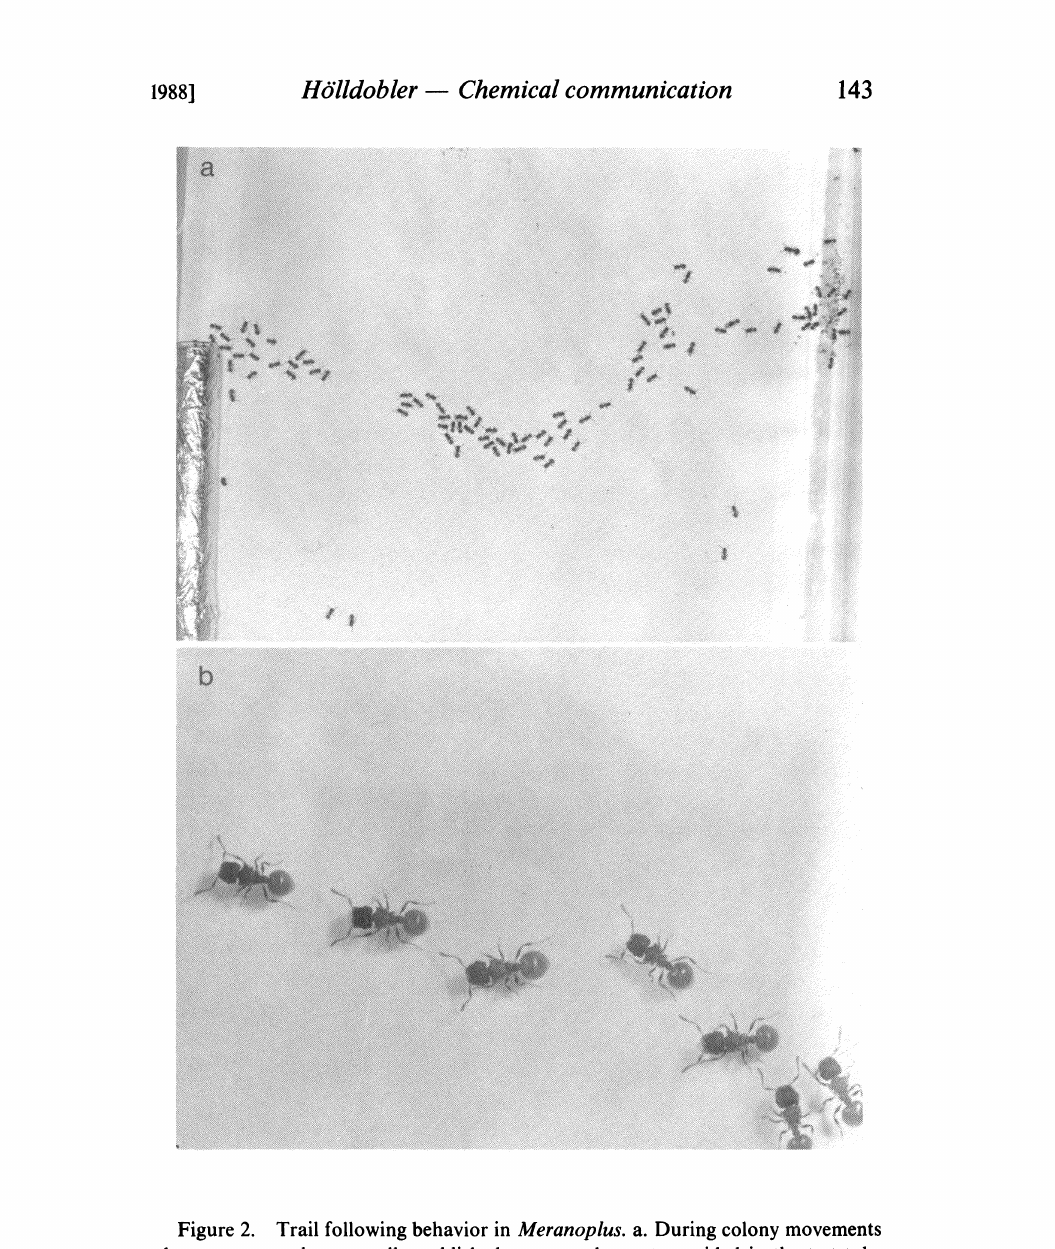
Figure 2. Trail following behavior in Meranoplus. a. During colony movements the ants move along a well established route to the nest provided in the test tube (covered with an aluminum foil), b. A trail laying recruiter moves from the nest to the food source and is followed by 6